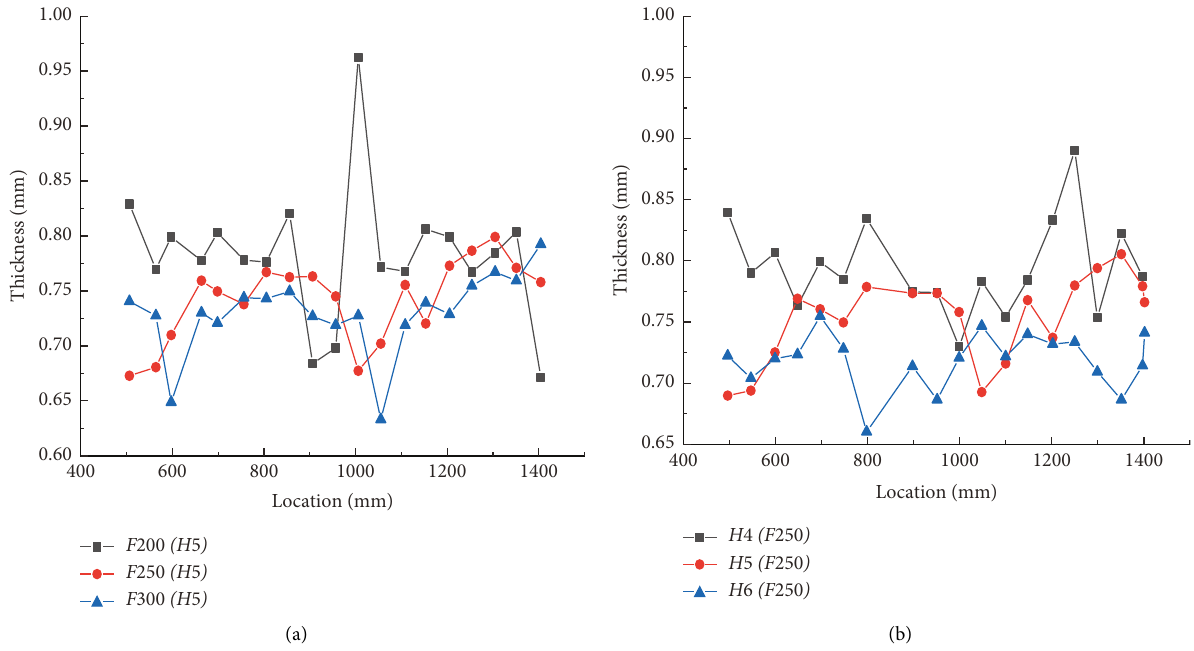
Figure 6: N -section thickness distribution curve. (a) Draw bead height 5 mm. (b) Constant side pressure of